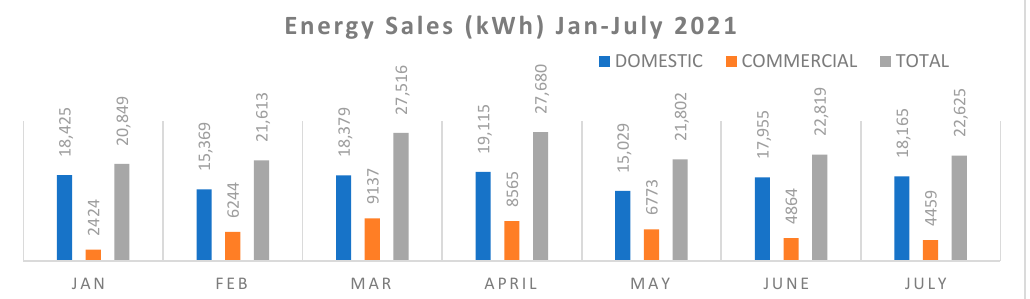
Figure 4. Energy Sales January–December 2020.